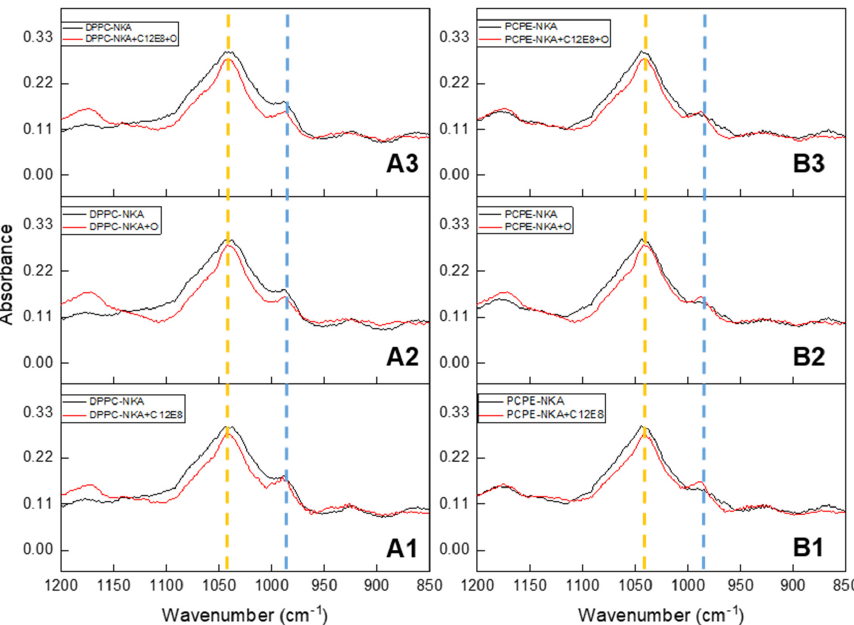
Figure 4. ATR-FTIR absorbance spectra of dehydrated minerals obtained from DPPC-NKA and DPPC:DPPE-NKA liposomes samples after 48 h’ incubation with ATP, 0.2% C 12 E 8 detergent and 3.0 mM Ouabain (NKA inhibitor) when described. Bands of HPO 32- (987 cm − 1 ) and PO 43- (1040 cm − 1 ) are indicated in blue and orange dash lines, respectively. ( A1–A3 ) DPPC-NKA liposomes. ( A1 ) Effect of C 12 E 8 . ( A2 ) Effect of Ouabain. ( A3 ) Effect of combination of 0.2% C 12 E 8 and 3 mM Ouabain. ( B1–B3 ) DPPC-DPPE-NKA liposomes. ( B1 ) Effect of 0.2% C 12 E 8 . ( B2 ) Effect of Ouabain. ( B3 ) Effect of combination of 0.2% C 12 E 8 and 3 mM Ouabain. In the figures, Black line was used for the control spectra with only NKA-liposome, A1 to A3 DPPC-NKA and B1 to B3 DPPC:DPPE-NKA ( ▬ ) and red line represent the spectra with 3 mM Ouabain or 0.2% C 12 E 8 ( ▬ ) .